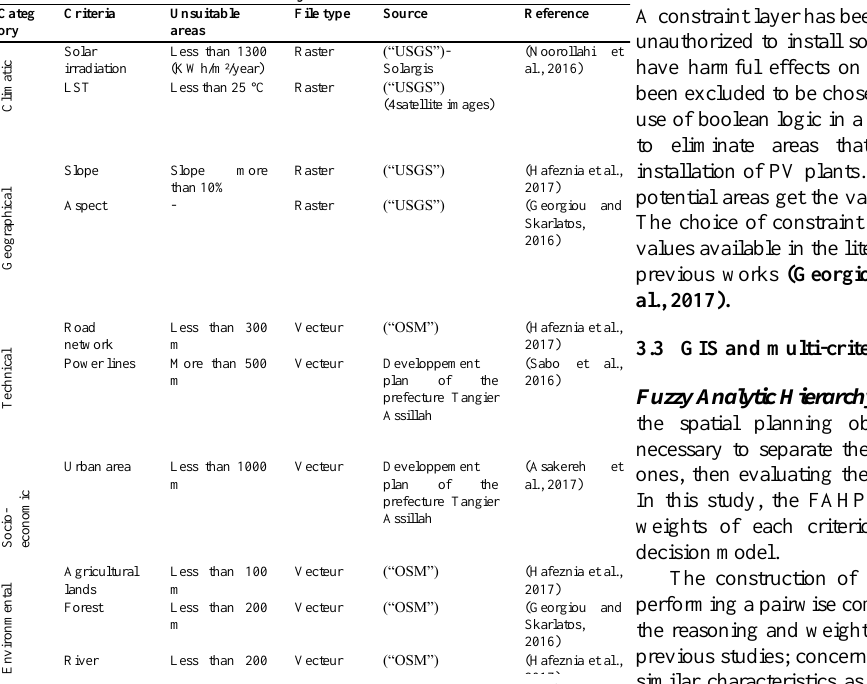
Table 1. Criteria used in this study.